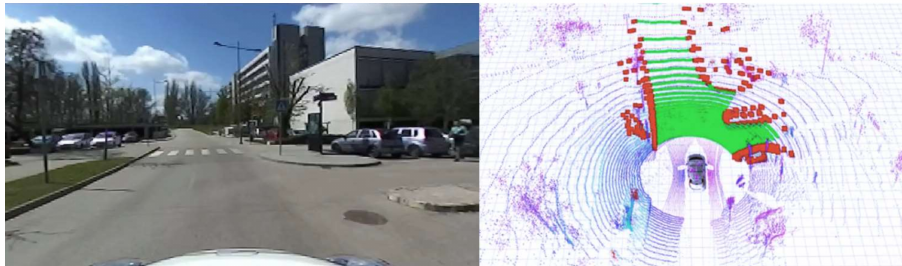
Figure 10. In-vehicle test of the method. On the ( left ) side, camera information is shown. On the ( right ) side, LIDAR 3D data are visible where the road (green) and sidewalk (red) are highlighted. The voxel scale is LIDAR intensity-based (location: University Campus, Gy˝or,